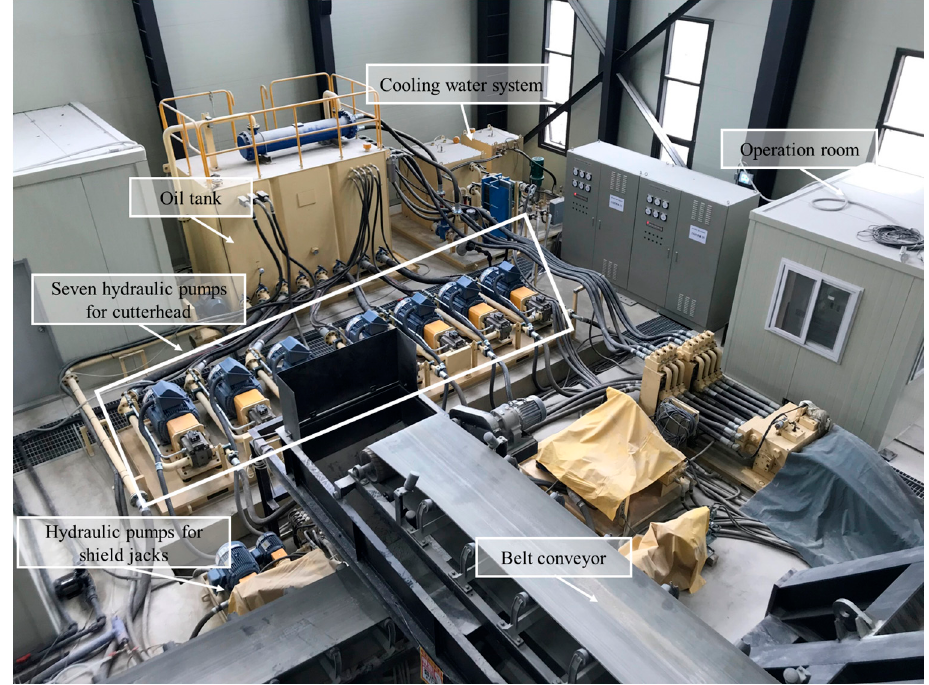
Figure 3. Hydraulic pumps and related units for cutterhead drive.